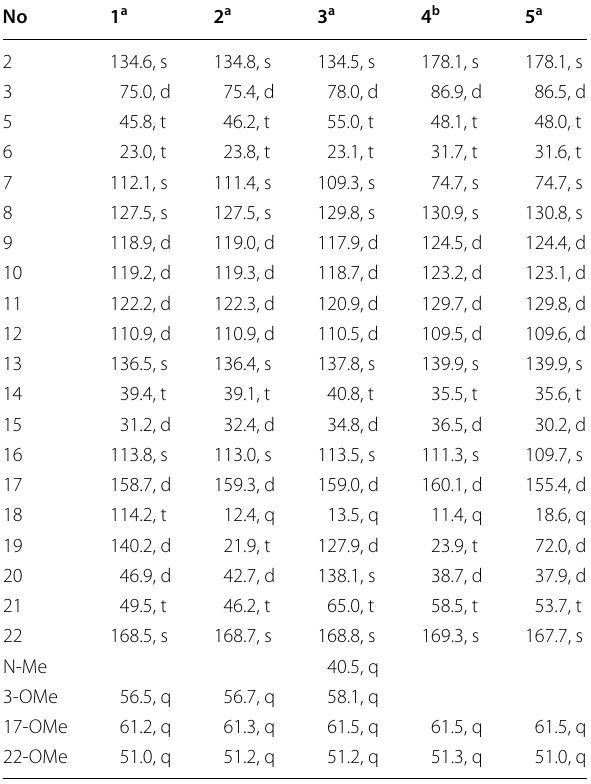
Table 2 13 C NMR spectroscopic data for compounds 1–5 ( δ in